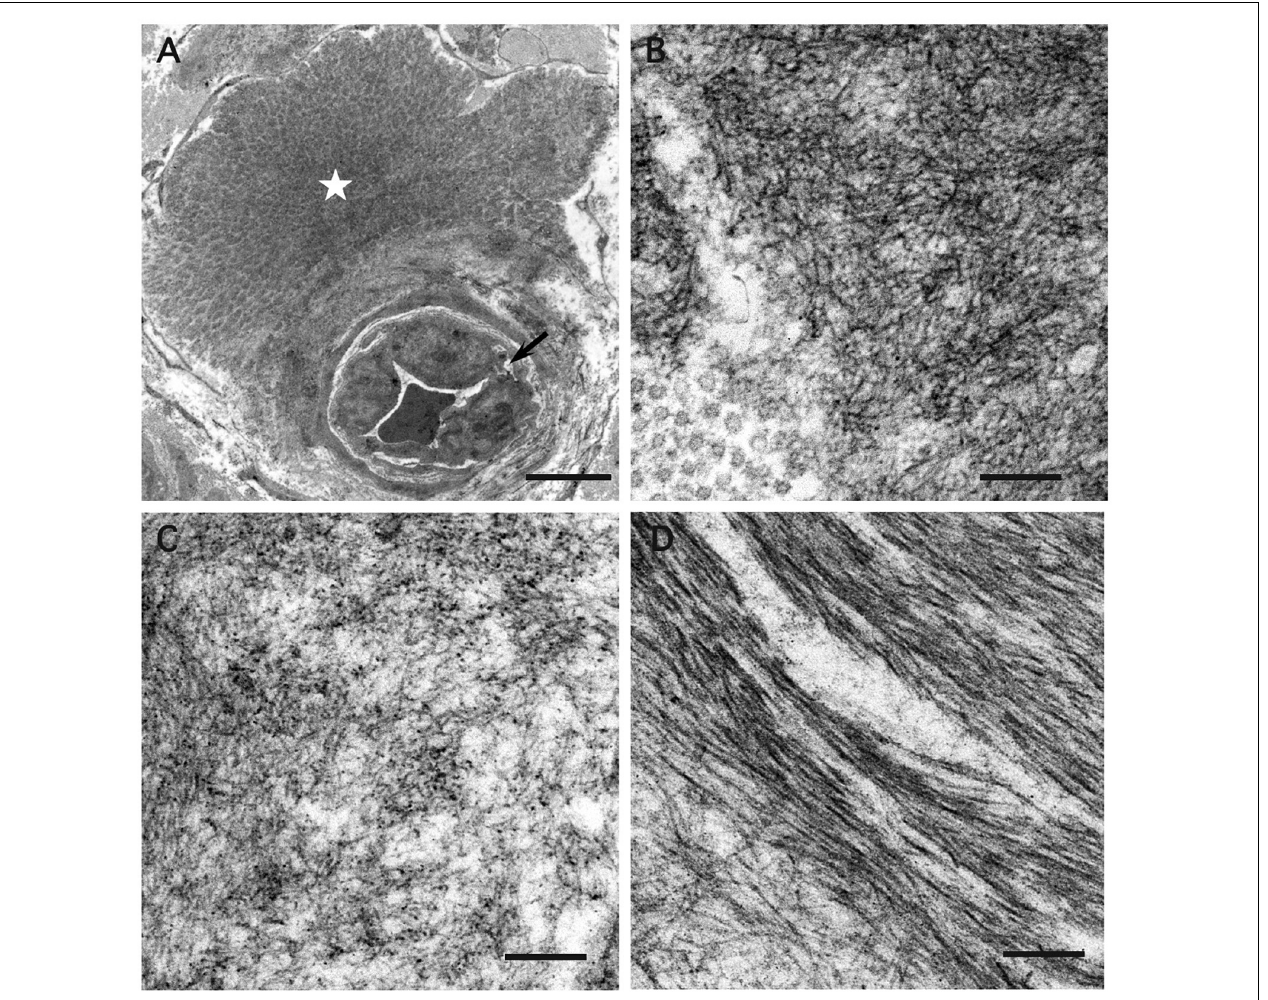
FIGURE 2 | Electron microscopic findings of amyloid fibrils in the endoneurium. Cross-sections of sural nerve biopsy specimens from patients with hereditary transthyretin amyloidosis (ATTRv). (A,B) A97S patients from Taiwan, (C) Late-onset V30M patient from a non-endemic area of Japan, and (D) Early-onset V30M patient from an endemic focus of Japan. A microvessel indicated by an arrow is apposed by a mass of amyloid fibrils (asterisk) (A) . Amyloid fibrils are generally short and thin in the A97S and late-onset V30M patients (B,C) , while they tend to be long in the early-onset V30M patient (D) . Uranyl acetate and lead citrate stain. Scale bars = 5 µ m (A) and 0.2 µ m (B–D)